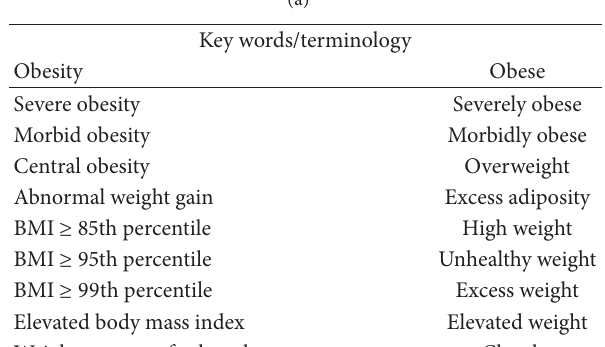
Table 2: Key terms and ICD-9 codes used to identify appropriate documentation within